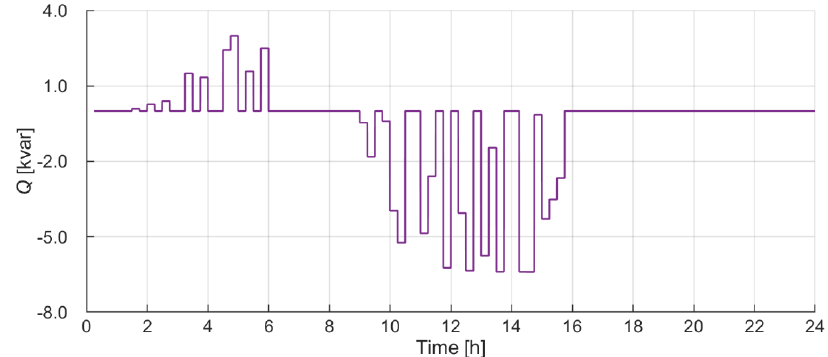
Figure 20. Daily reactive power variation of the energy storage unit ES_529 (installed in node 529); profile B.